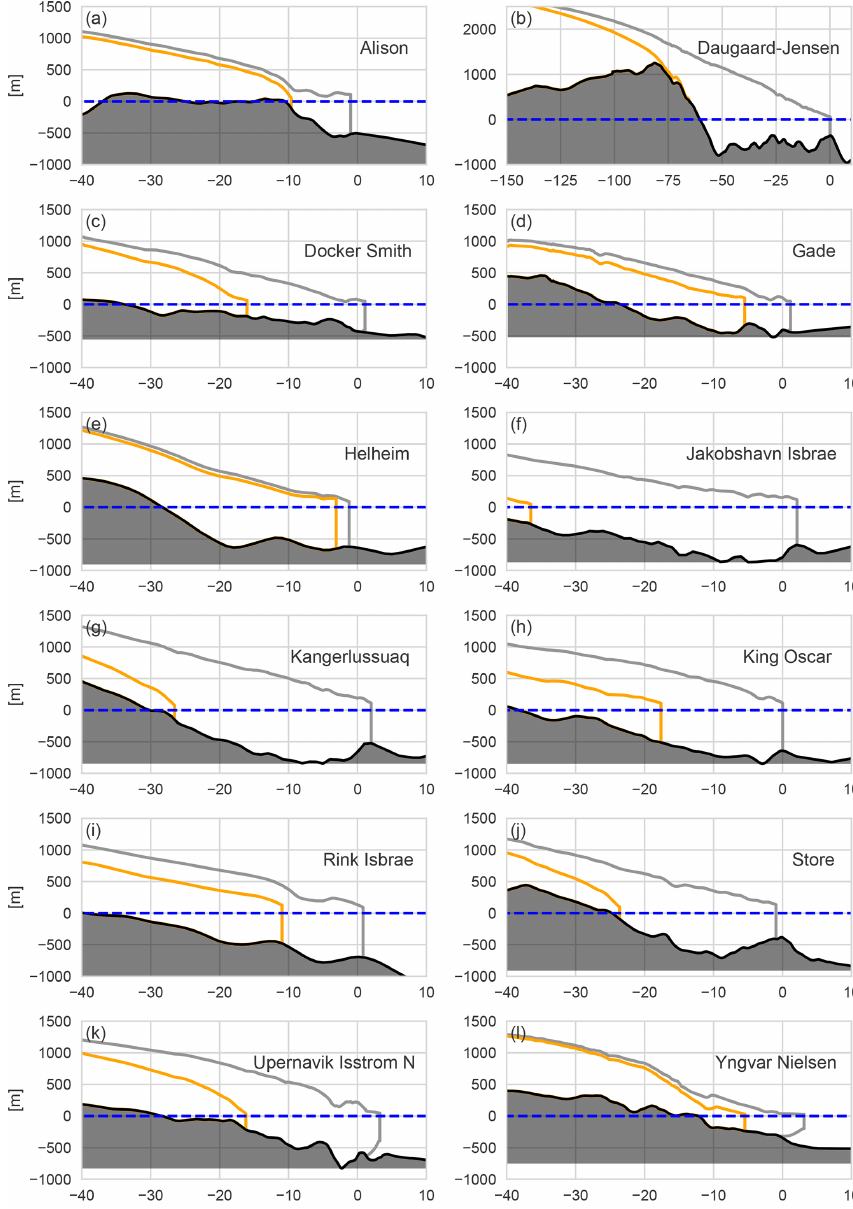
Figure 7. Retreat of median range (see footnote 1) SLR scenario for RCP8.5 forcing scenarios (SMB, ocean temperature and subglacial discharge) for all 12 glaciers in 2100 (orange). Corresponding initial states are depicted in grey. Daugaard-Jensen showed full retreat of over